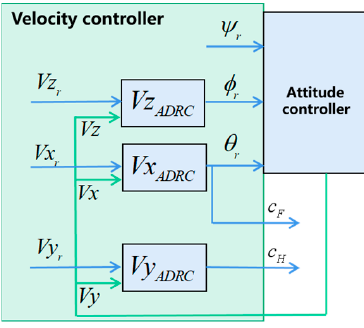
Figure 6. Velocity controller.